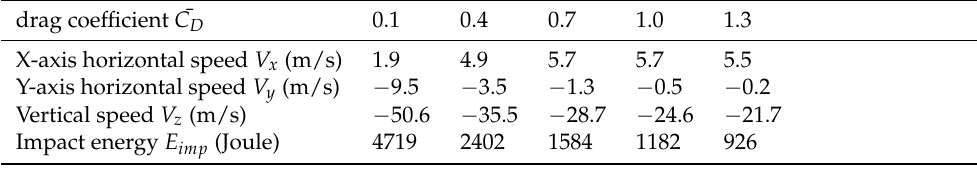
Table 6. A case of velocity and energy when crashing to the ground for different ¯ C D